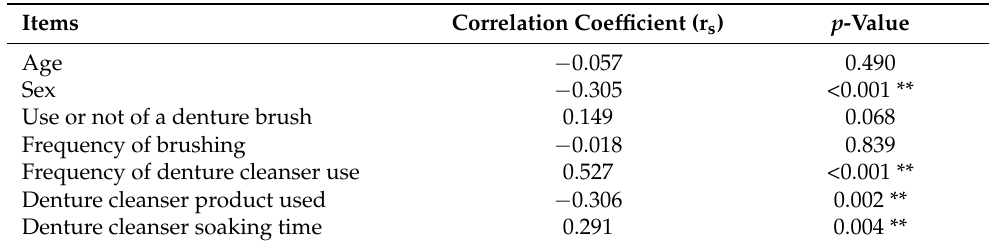
Table 3. Relationships between the number of Candida spp. on dentures and each surveyed